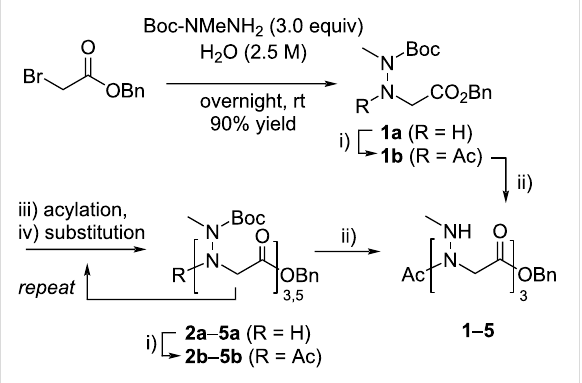
Scheme 1: Submonomer synthesis used for the construction of peptoids 1 – 5 containing N -methylamino side chains.